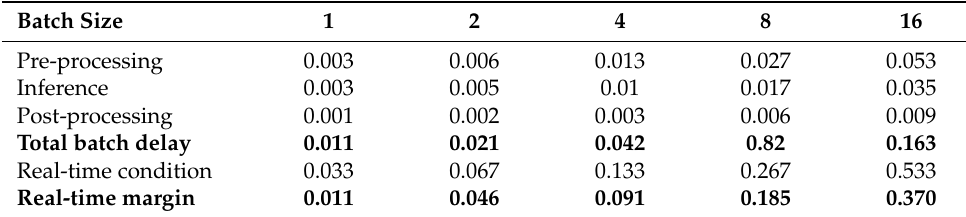
Table 2. Delays and real-time constraints on a 2080